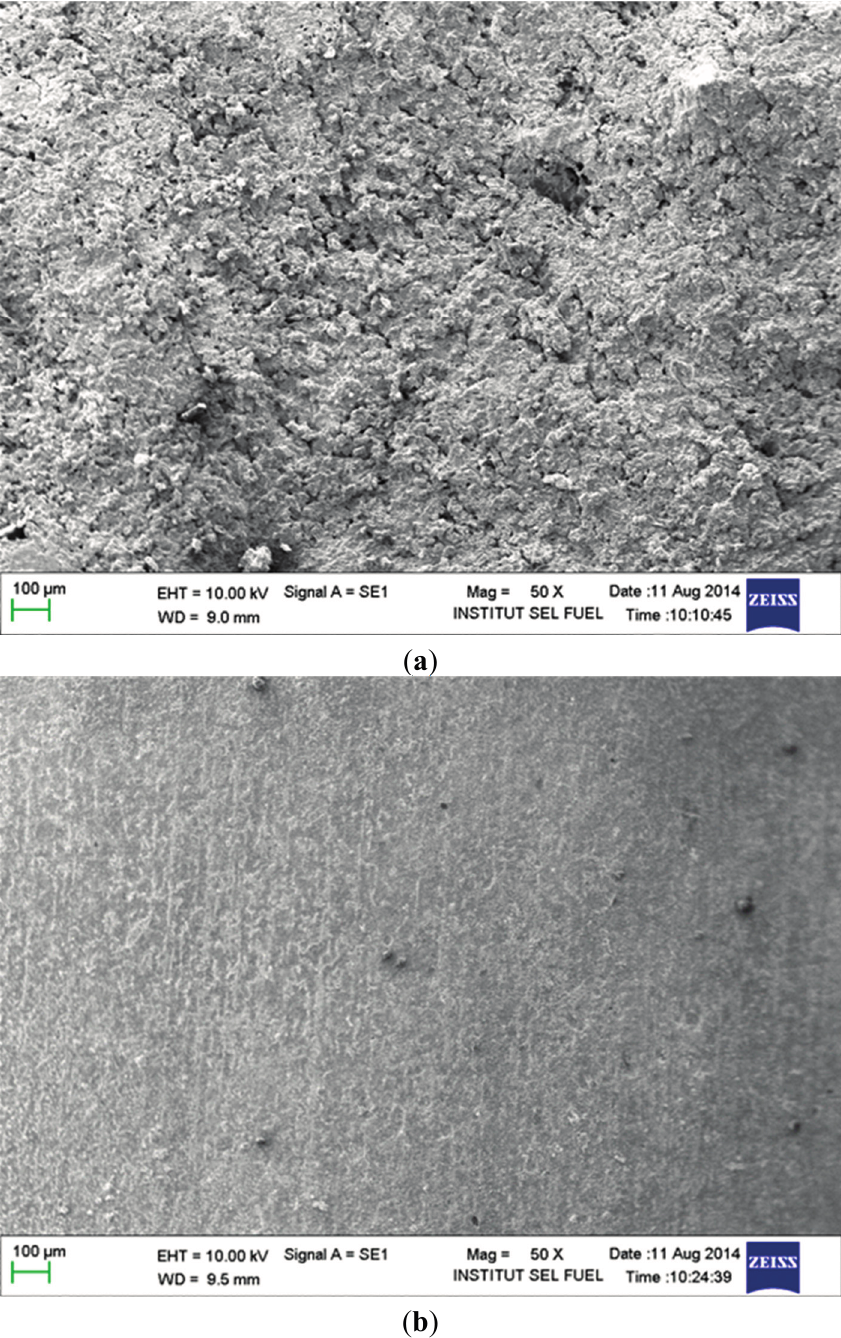
Figure 4. The SEM micrographs 5000×, for mild steel in 1.0 M HCl with 0.5 mM of the corrosion inhibitor at 30 °C for 5 h as immersion time. ( a ) absence the inhibitor; ( b ) in presence the